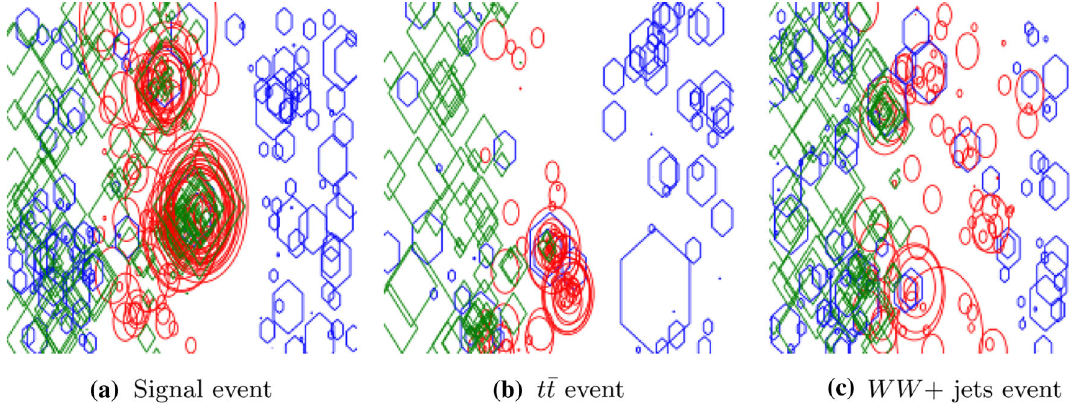
Fig. 2 Example of an abstract jet image in the (η,φ) plane. Green polygons are representative of photons, red circles are charged particles while blue hexagons indicate neutral hadrons. The radius of the poly- gons is proportional to the energy left by the particle in the calorimeter